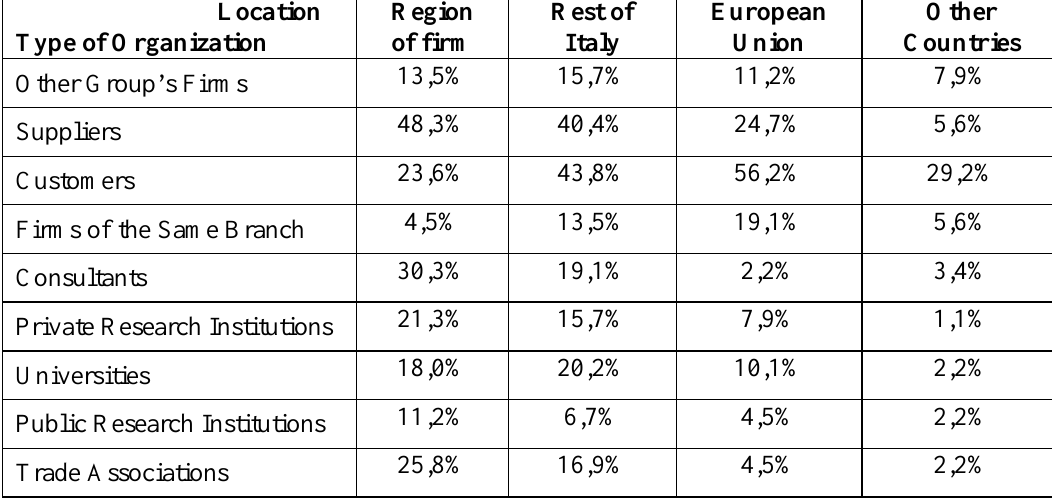
Table 6: Partnerships for Innovation Activities by Geographical Location and Type of Organization (% of Total